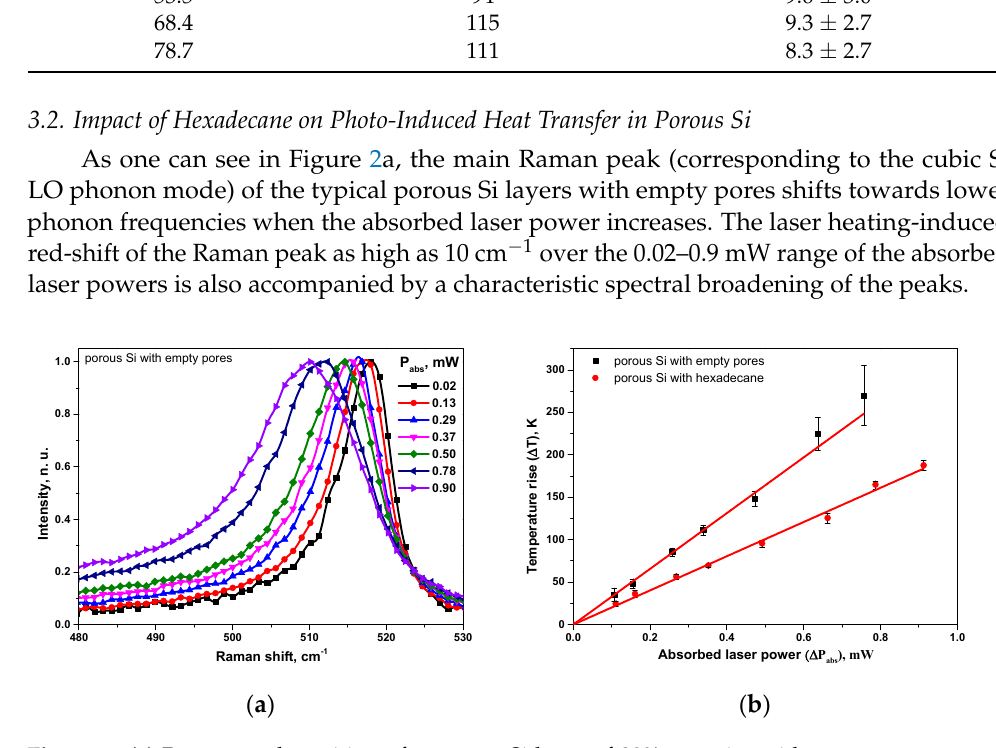
Figure 2. ( a ) Raman peak position of a porous Si layer of 80% porosity with empty pores at various absorbed laser power; ( b ) temperature rise induced by absorbed laser power for porous Si layers with empty pores and pores filled with hexadecane (4 repetitions were performed for each experi- mental point).